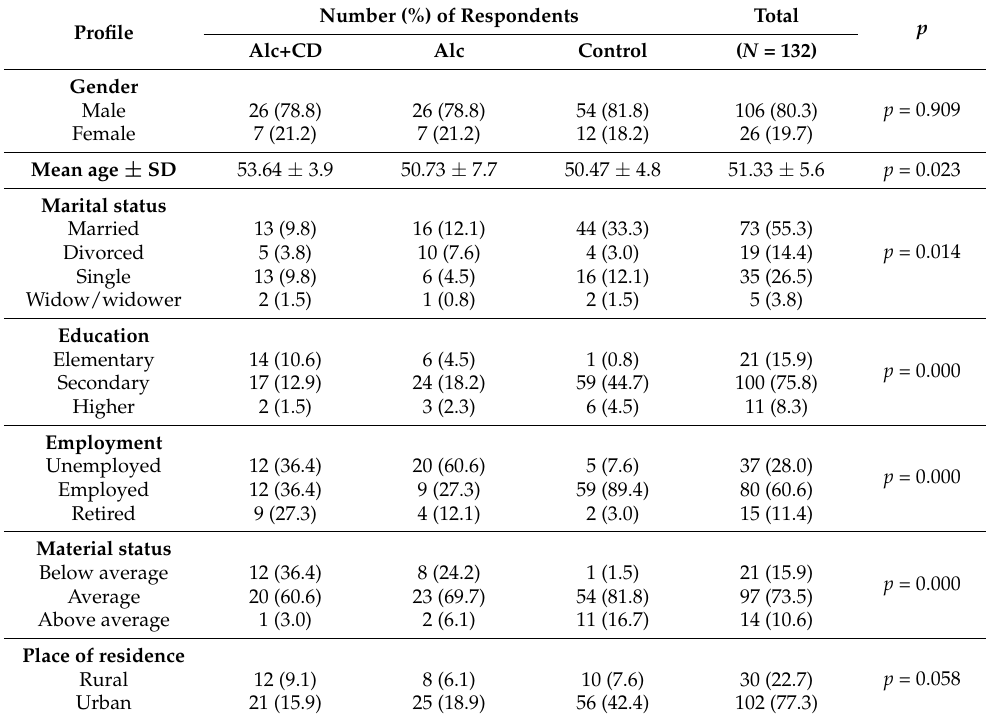
Table 1. Sociodemographic characteristics of study